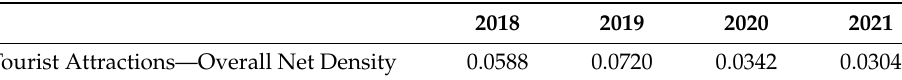
Table 2. Overall network density of tourism flows.